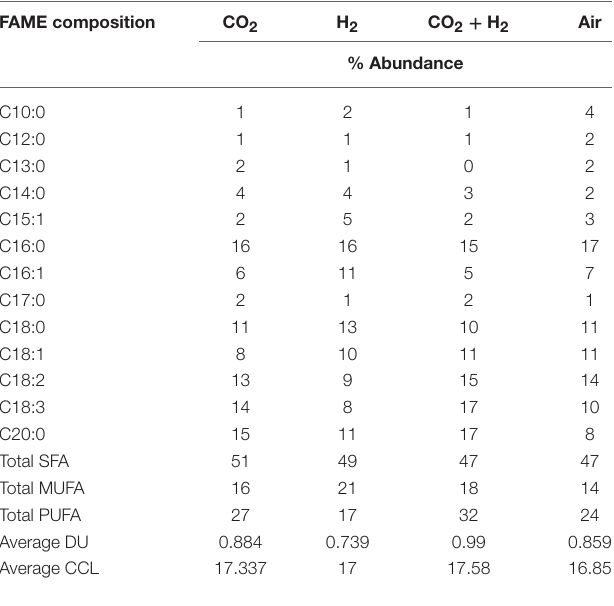
TABLE 2 | FAME compositional distribution with desaturation, average carbon chain length, average degree of unsaturation for lipids extracted from samples grown under different headspace gas